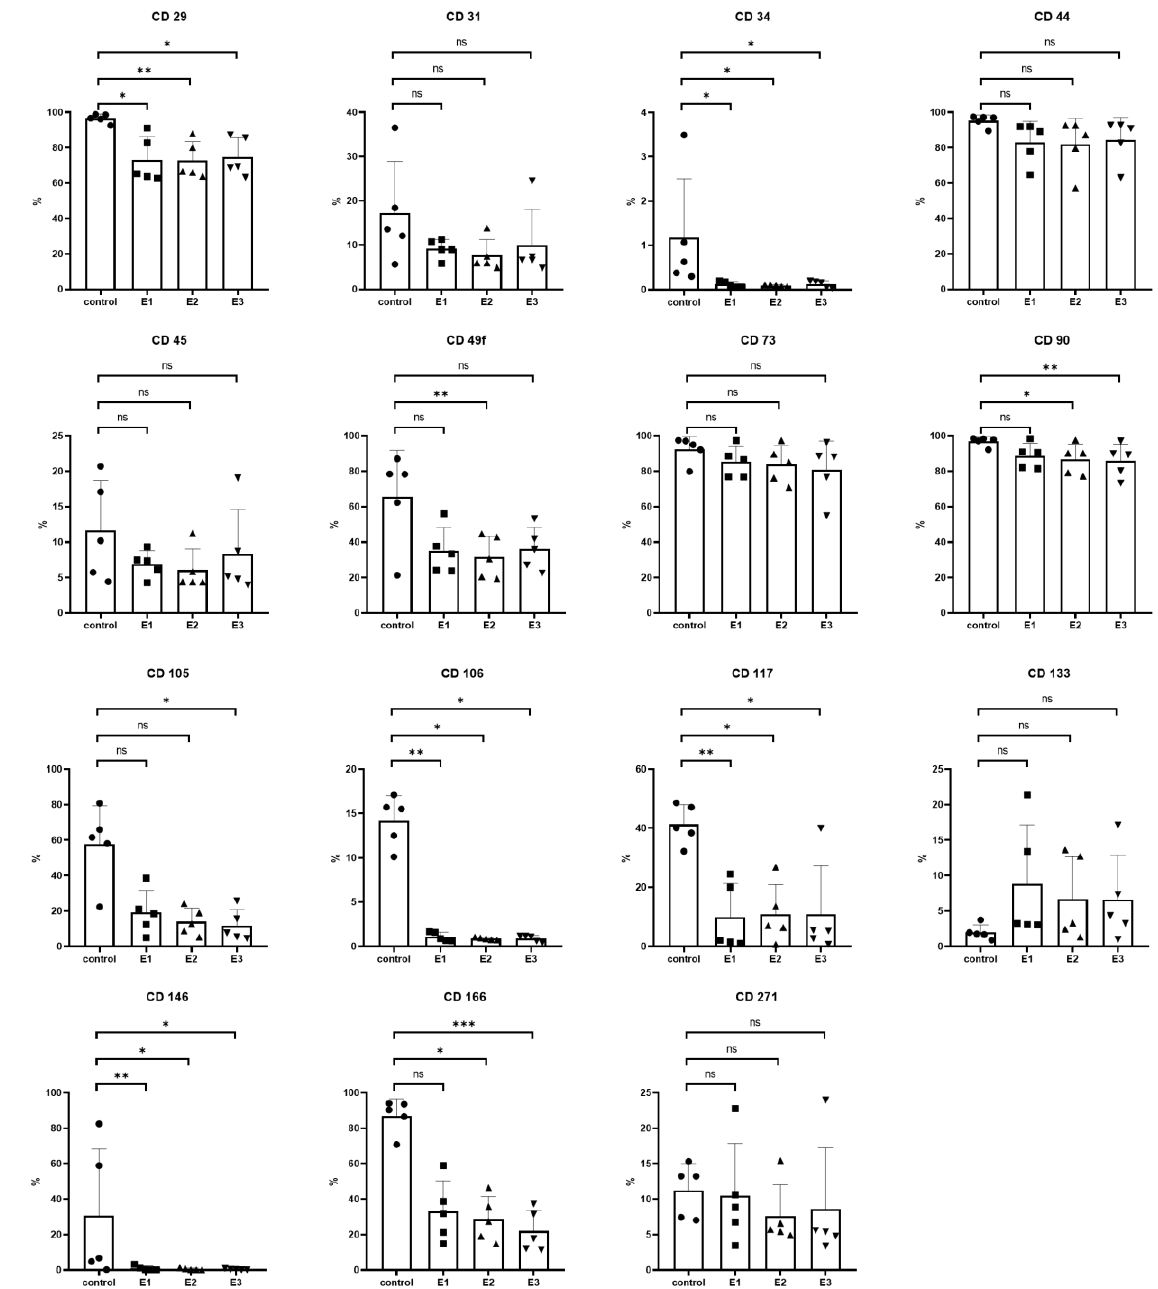
Figure 5. Flow cytometry analysis in the 6th passage of the experiment. The graphs demonstrate the percentages of cells stained by fluorochrome-labeled antibodies against particular cell surface markers in the population. The group mean is plotted as a column, SD is plotted as an error bar, and individual values are plotted as symbols (circle, triangle, and cube). Cells were cultivated in the control (control) and experimental media 1–3 (E1–3). Statistical analysis was performed using Friedman’s test followed by Dunn’s post hoc test; * p < 0.05, ** p < 0.005, *** p < 0.001.